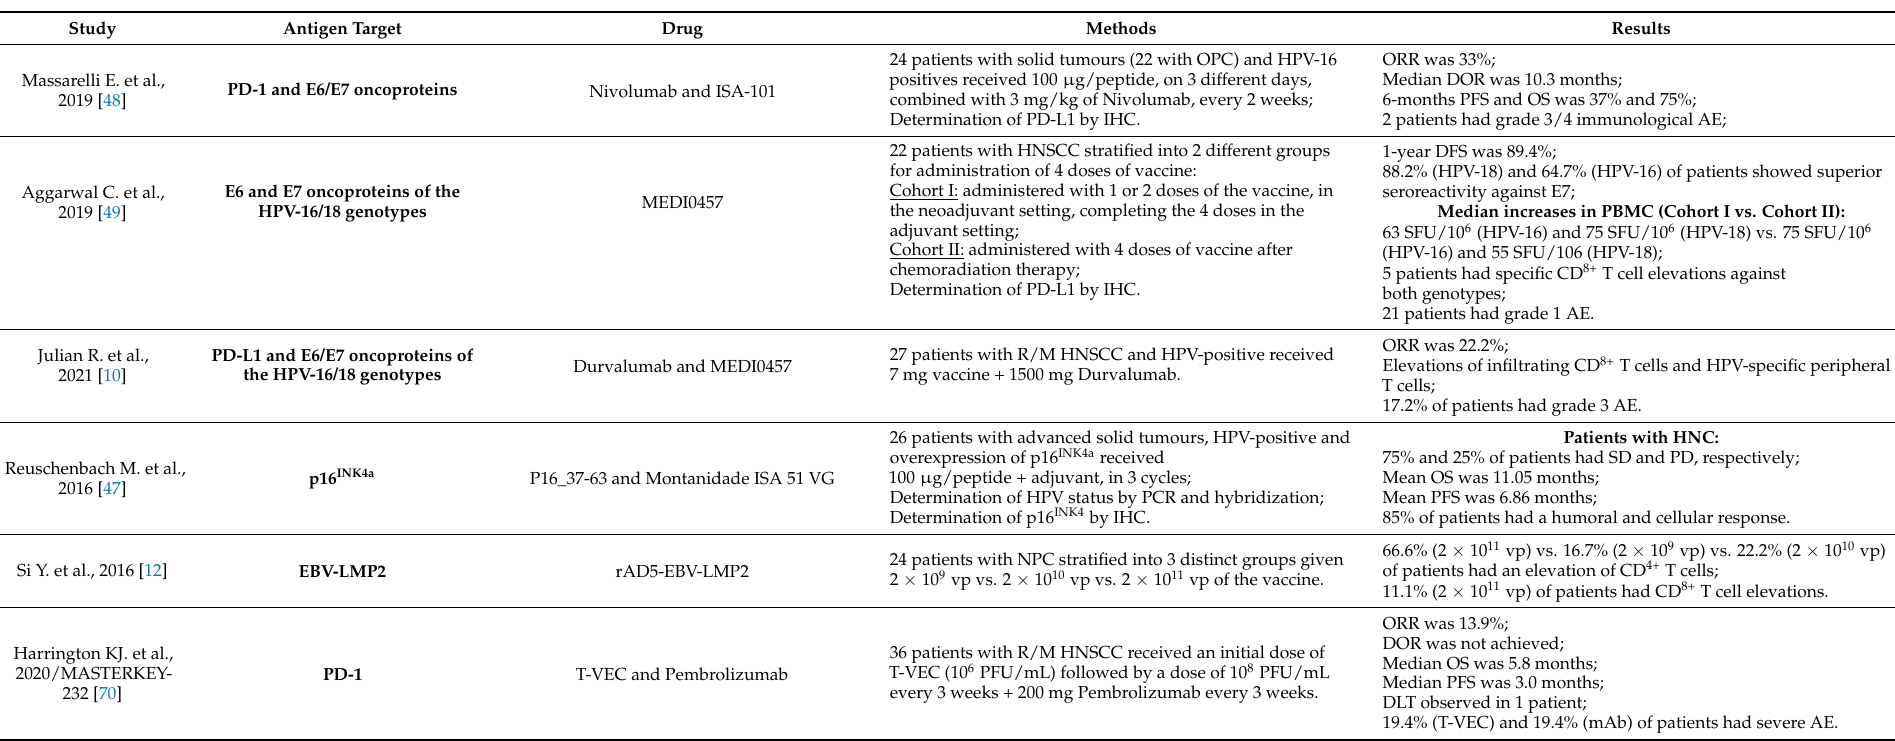
Table 3. Recent studies of therapeutic vaccines, targeting human papilloma viruses and Epstein–Barr, and oncolytic viruses, such as